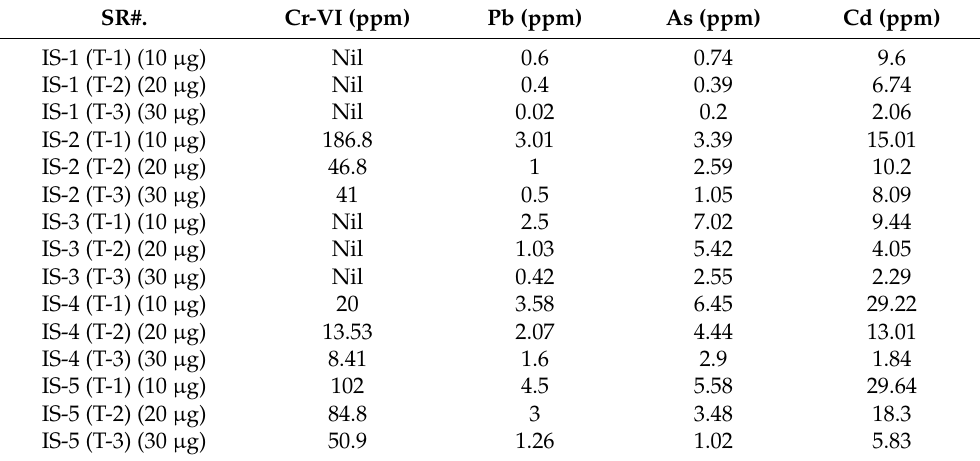
Table 3. Final concentrations of heavy metals detected after treatment of industrial wastewater by ZVI-NPs.